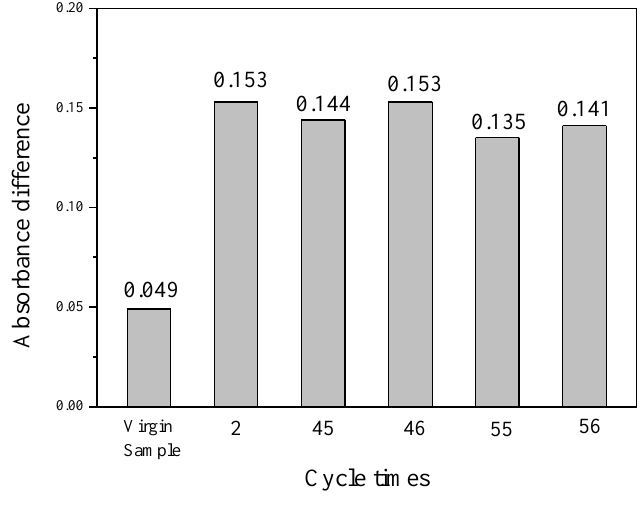
after 20 min of NH adsorption. 3 3